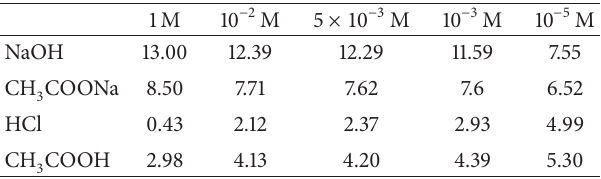
Table 1: pH values of desorption